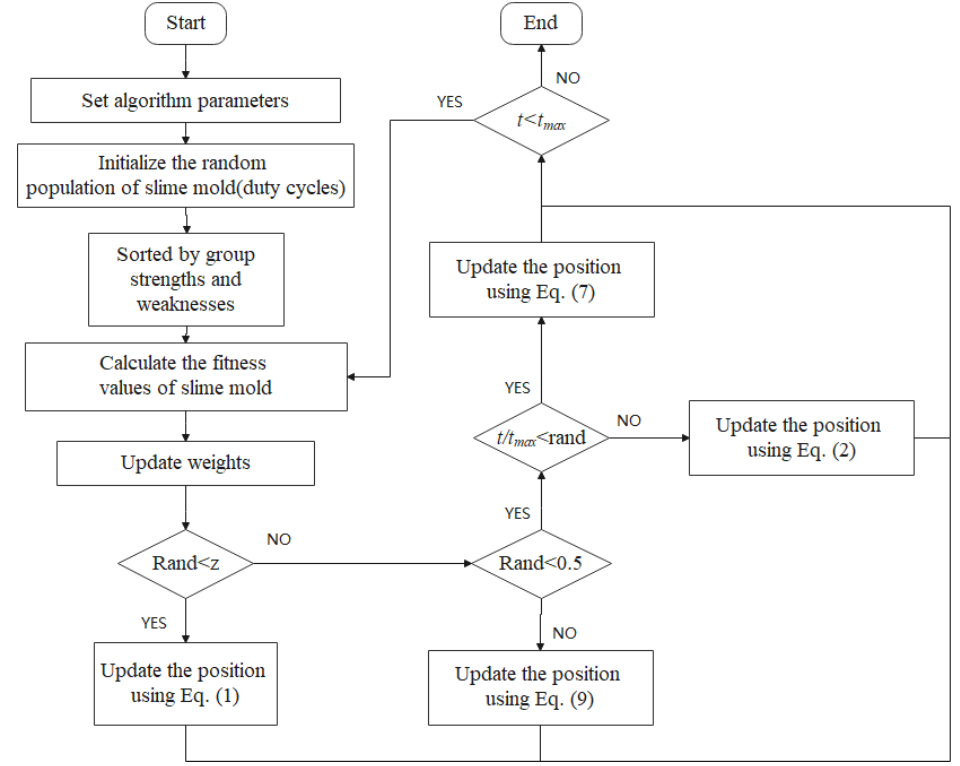
Figure 6. Flow chart of the improved slime mold algorithm for optimal MPPT control.